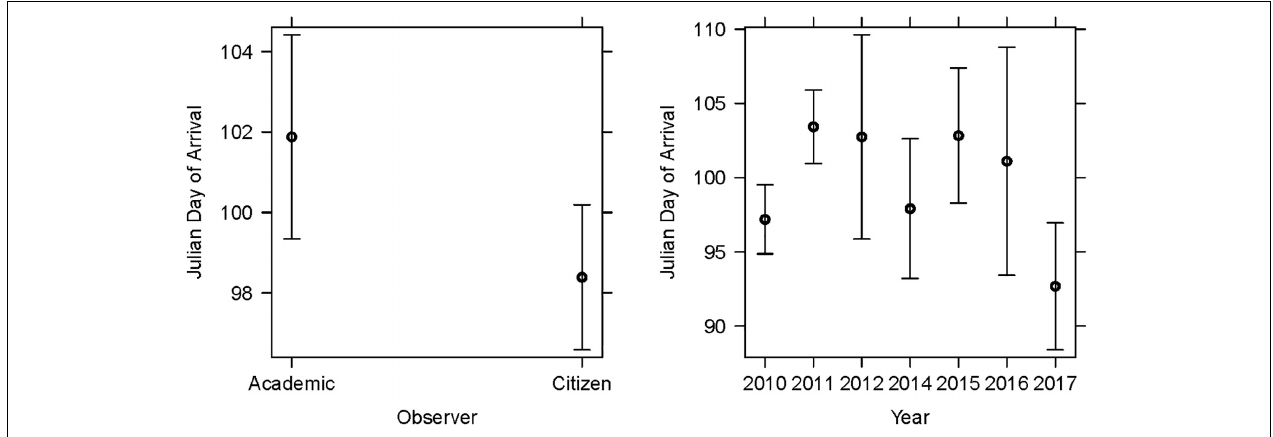
FIGURE 4 | The LMM on arrival dates featured observer category and study year as significant explanatory terms. The overall R 2 c of the LMM was 0.21. Model details in Table 1A